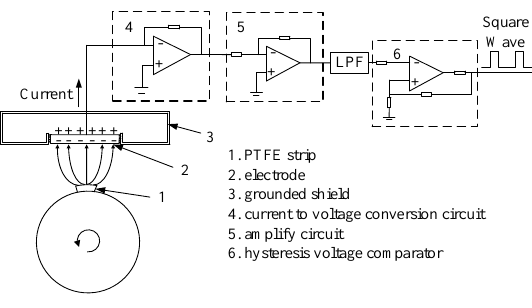
Figure 4. Measurement principle.